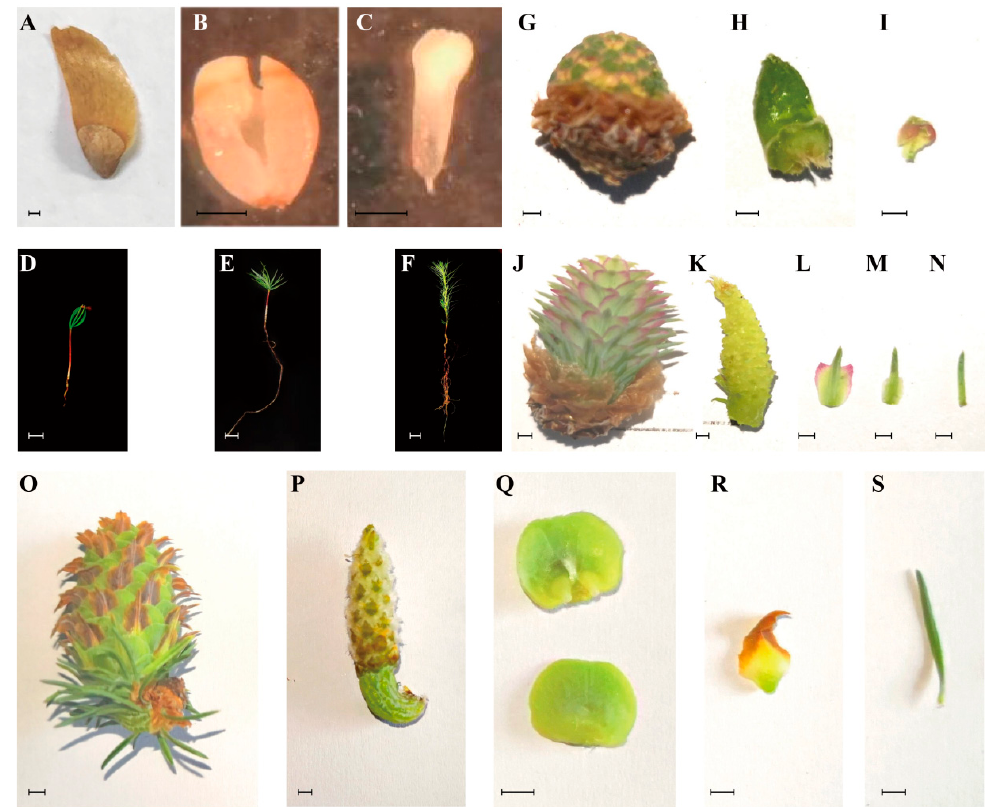
Figure 5. Plant materials used for LaDAL1 expression pattern analysis during the life cycle of Larix kaempferi : ( A ) mature seed, ( B ) endosperm from a mature seed, ( C ) embryo from a mature seed, ( D ) 22-day-old seedling, ( E ) 54-day-old seedling, ( F ) 74-day-old seedling. ( G ) male cone collected on 13 April 2020, ( H ) axis of a male cone, ( I ) microsporophyll, ( J ) female cone collected on 13 April 2020, ( K ) axis of a female cone, ( L ) ovuliferous scale, ( M ) bract scale from a female cone, ( N ) needle from a female cone, ( O ) immature seed cone collected on 14 May 2020, ( P ) axis of a seed cone, ( Q ) seed scales, ( R ) bract scale from a seed cone, ( S ) needle from a seed cone. Black scale bars, 1 mm; white scale bars, 1